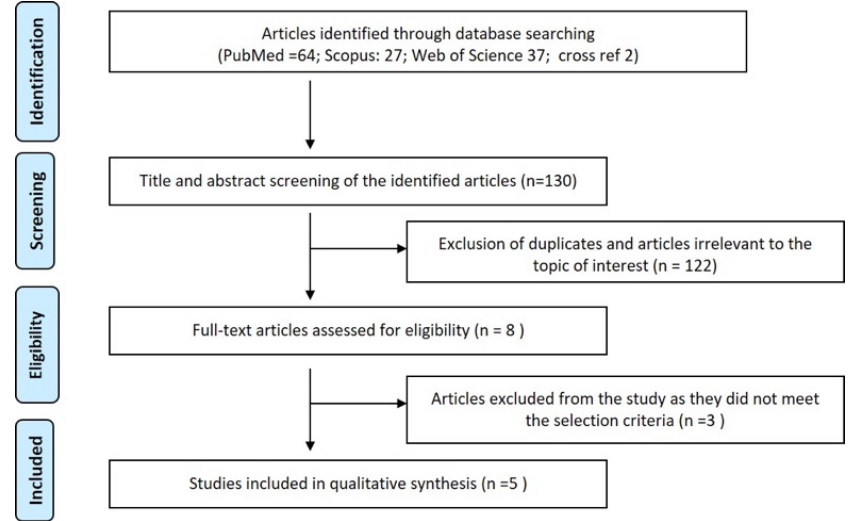
Figure 1. PRISMA flowchart.